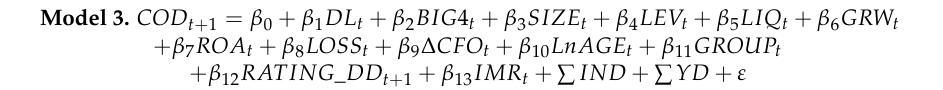
Table 8. Cluster-adjusted ordinary least square (OLS) regression results for